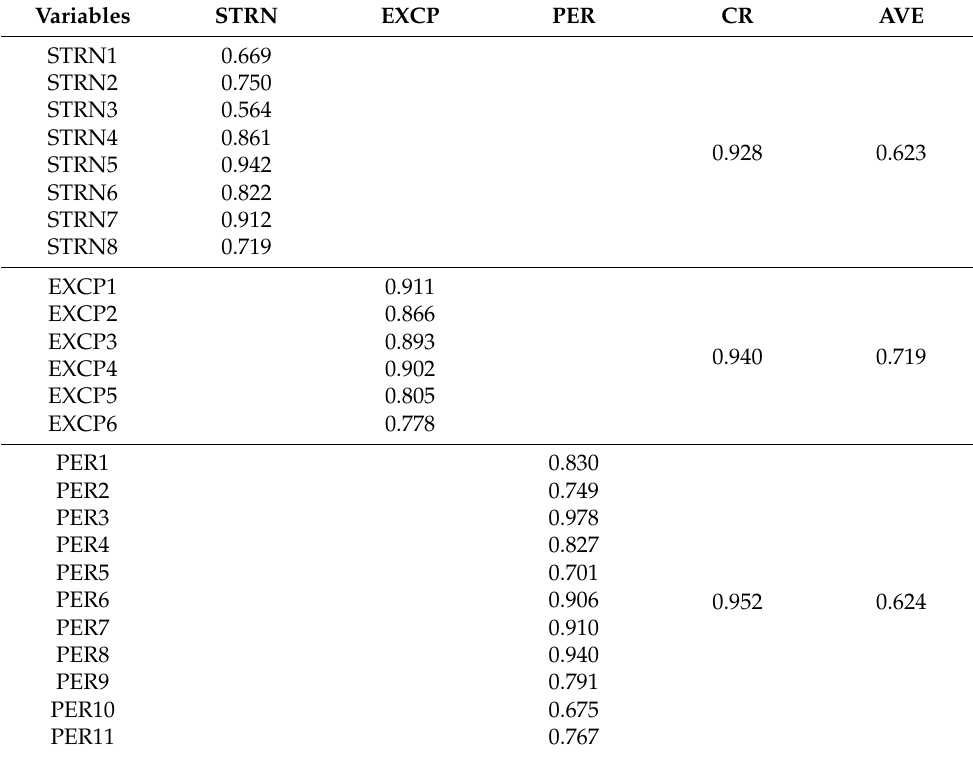
Table 3. Factor loadings and convergent validity.